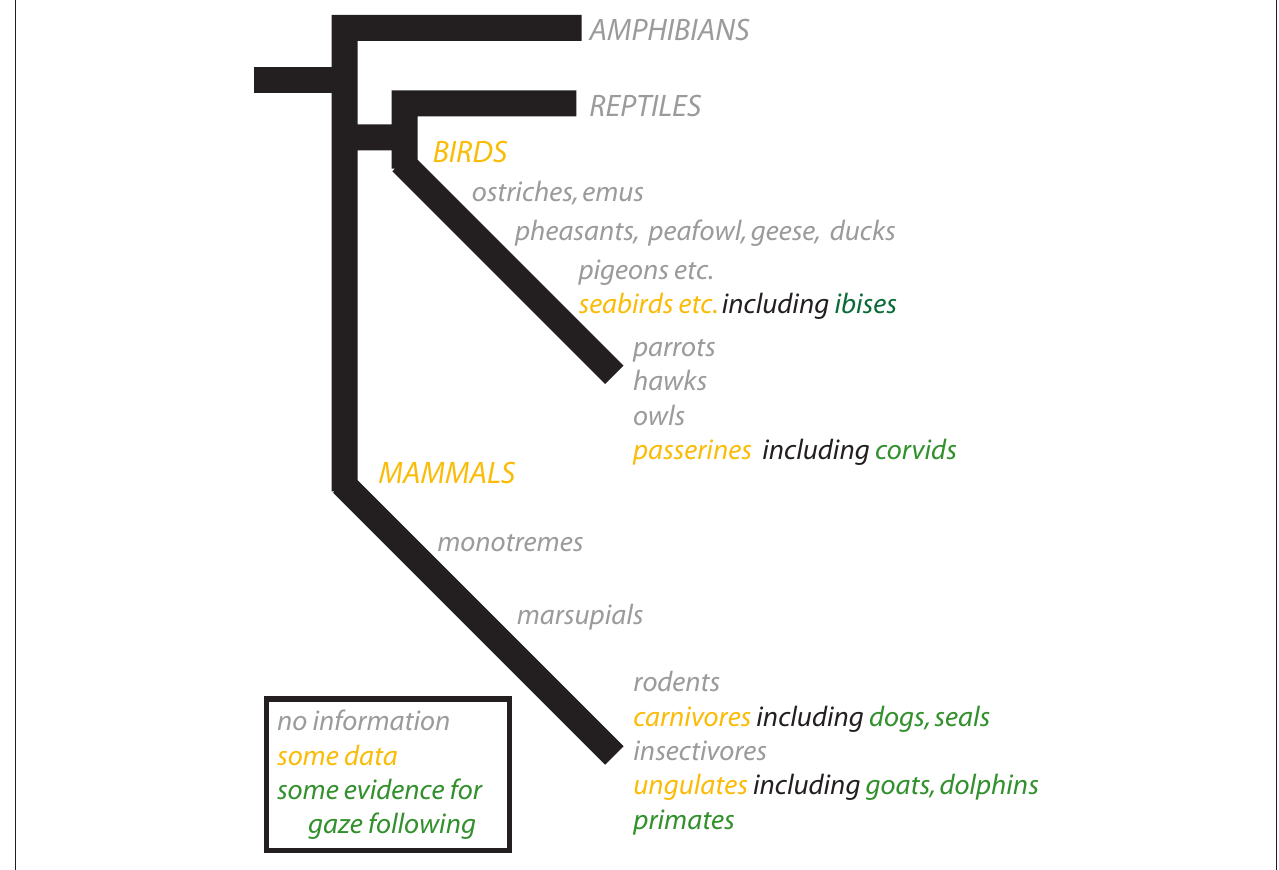
FIgure 2 | Phylogeny of vertebrate gaze following. Though the most robust evidence for gaze following has emerged from primates, other mammals and birds have also been found to follow gaze. Evidence comes primarily from three groups: domestic mammals including goats and dogs, captive cetaceans